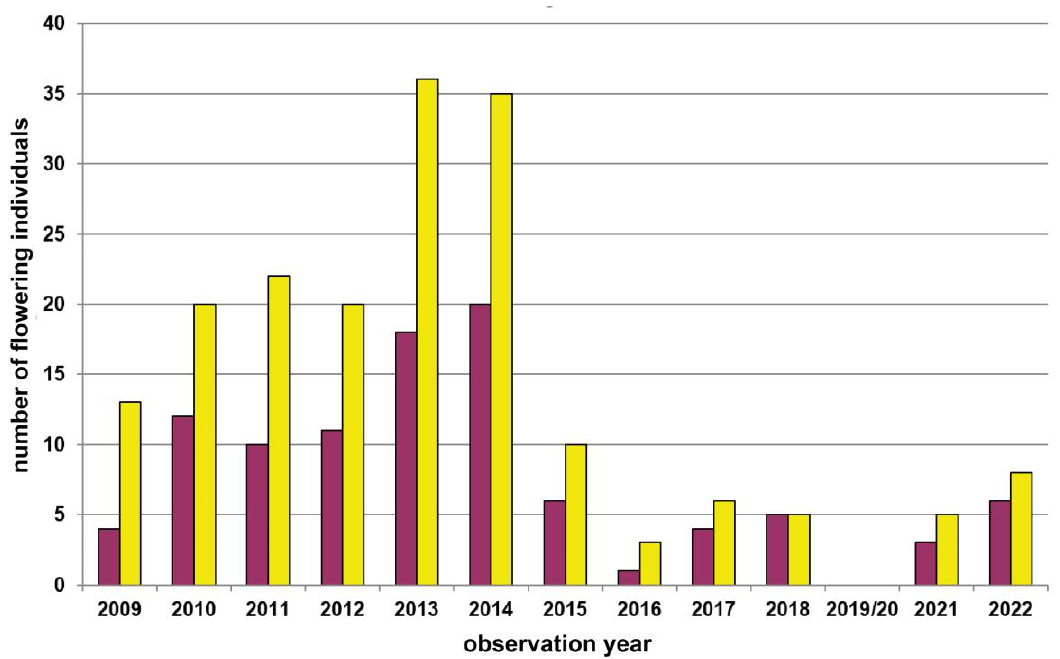
Figure A6. Population census (2009–2022) of the Dactylorhiza sambucina -population Groisbach (patch I) in the Wienerwald region. This population was not visited by us in the years 2019/2020. Red columns = red-flowering plants and yellow columns = yellow-flowering plants.